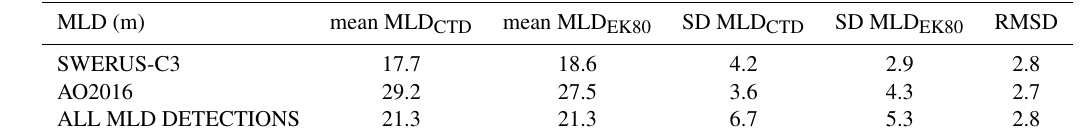
Table 2. Statistics for MLD EK80 and MLD CTD with the four outliers (Fig. 3) excluded; all units are meters.